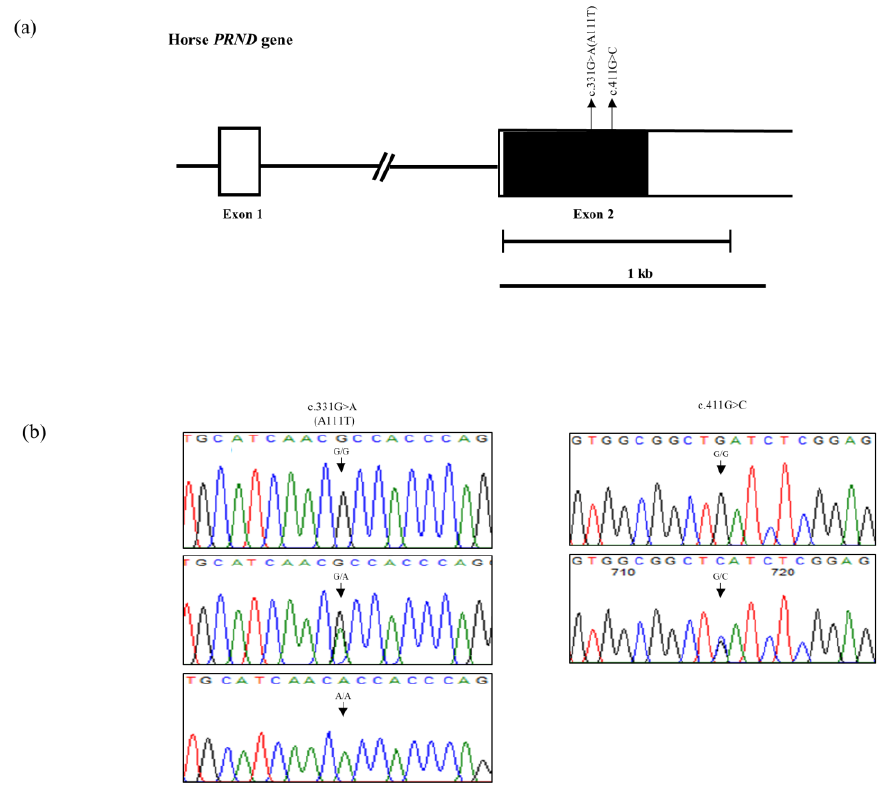
Figure 1. Gene map and polymorphisms identified in the horse prion-like protein ( PRND ) gene on chromosome 22. ( a ) The open reading frame (ORF) is indicated by a shaded block, and the 5′ and 3′ untranslated regions (UTRs) are represented by white blocks. Arrows indicate the novel polymorphisms found in this study. ( b ) Electropherograms showing the two novel single nucleotide polymorphisms (SNPs) identified in this study. left panels; c.331G > A (A111T), right panels; c.411G > C.